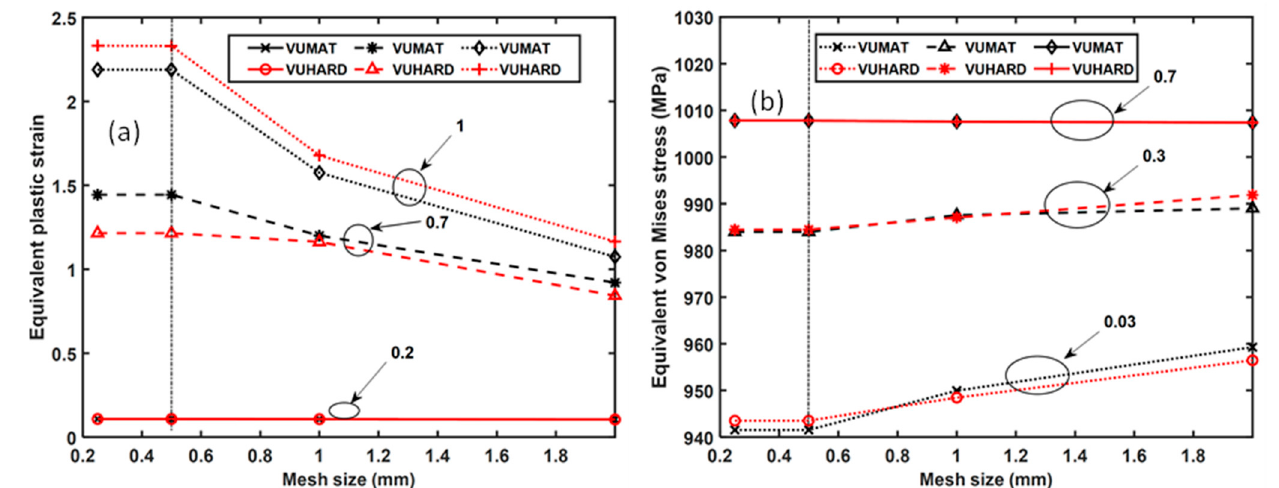
Figure 18. The mesh convergence analysis for equivalent ( a ) plastic strain at model normalised lengths of 0.2, 0.7, and 1 and ( b ) von Mises stress at normalised lengths of the models of 0.03, 0.3, and 0.7 for the VUMAT and VUHARD subrou- tines.